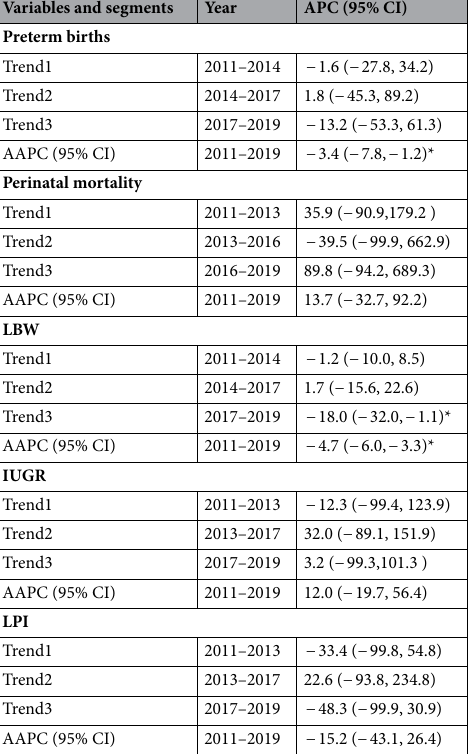
Table 2. Trends of adverse perinatal outcomes (preterm births, perinatal mortality, LBW, IUGR, and LPI) using joinpoint regression analysis from 2011–2019. APC annual percentage change, APPC average annual